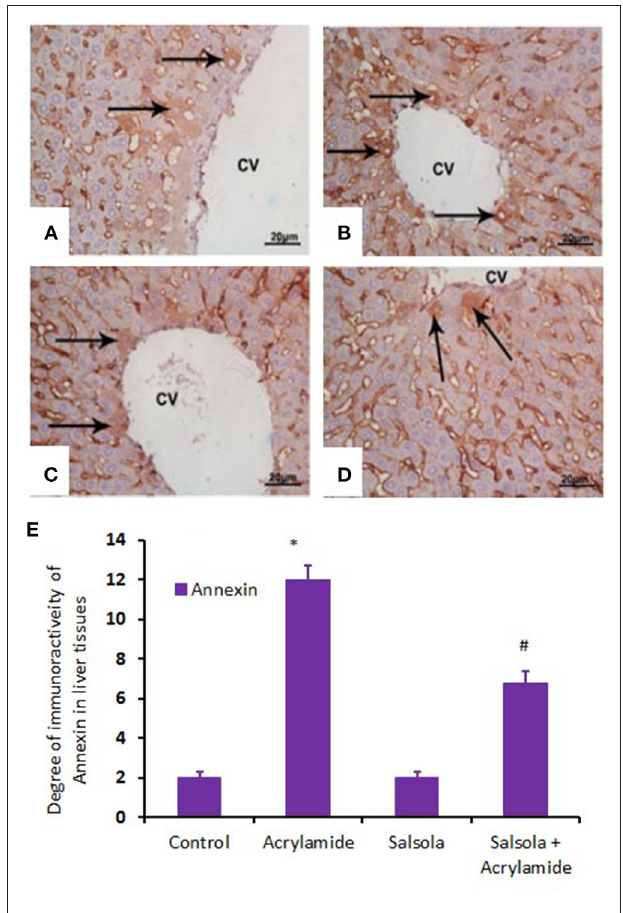
FIGURE 8 | Photomicrographs of hepatic sections immunostained with annexin antibody in the control group (A) , the Salsola -treated group (C) , the acrylamide-treated group (B) , and the group co-treated with Salsola and acrylamide (D) . The intensity of immunostaining was weak in the control and Salsola -treated groups (A,C) , strong in the acrylamide-treated group (B) , and reduced to weak or moderate in the co-treated rats (D) . Reactive liver cells (arrows) are frequently seen next to central veins (CVs). Scale bar = 20 µ m (original magnification = 200 × ). The degree of positive immunoreactivity for annexin is graphed in (E) . Densitometric values are statistically significant at * p < 0.05 vs. the control and Salsola -treated groups; # p < 0.05 vs. the acrylamide-administered group.